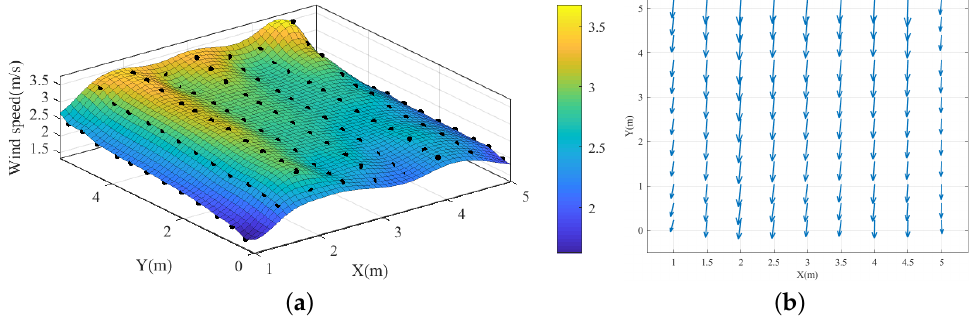
Figure 3. Wind field in STAr. ( a ) 3D wind field distribution. The black dots represent the monitoring sites. The color is used to show the magnitude of the wind speed. ( b ) display of wind direction and corresponding wind speed in the pool area.